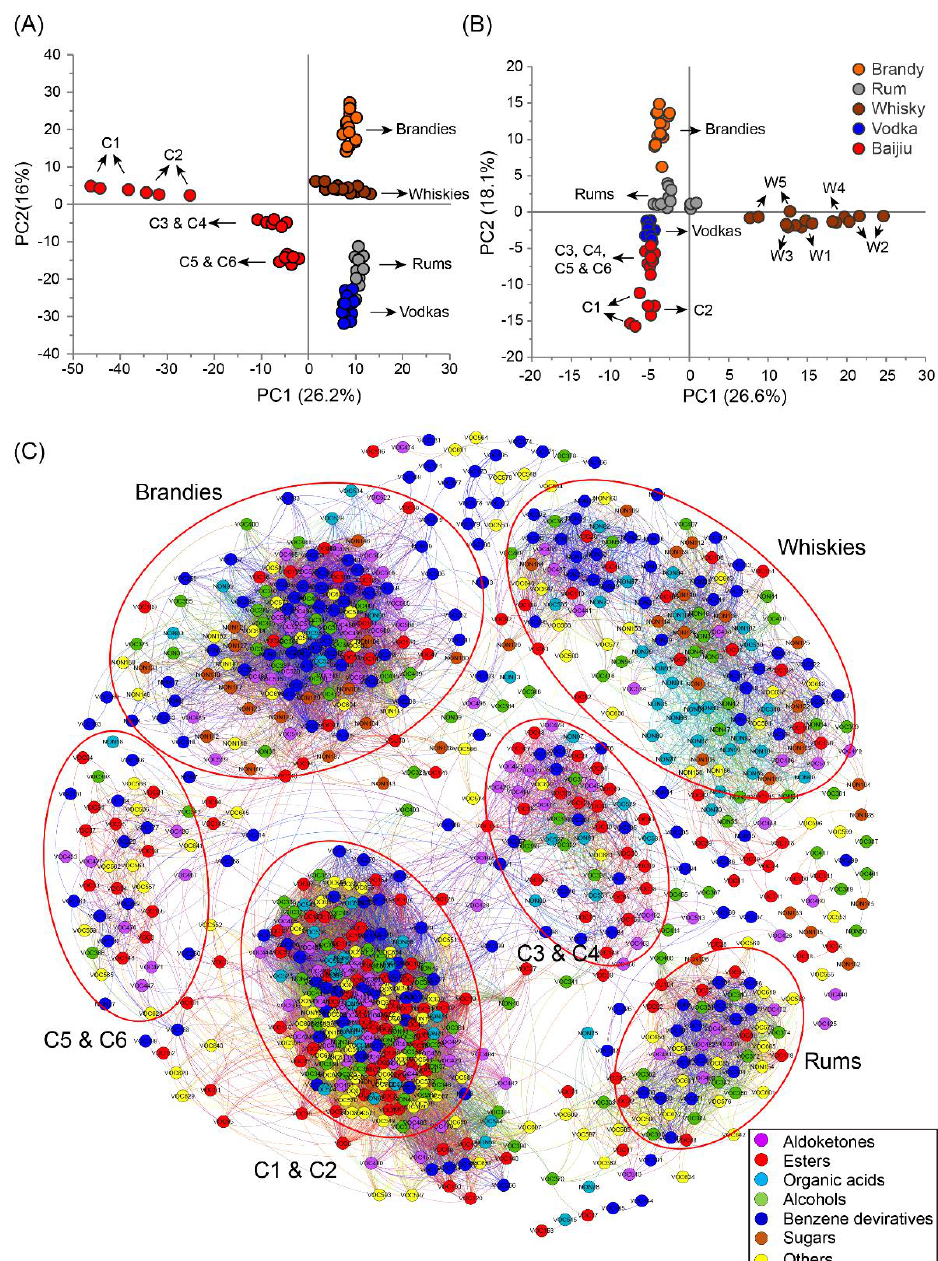
Figure 3. Principal component analysis (PCA) and correlation network analysis of 24 distilled liquors, including 6 Chinese baijius and 18 Western liquors. ( A ) Plot of PCA scores of VOCs detected by HS-SPME-GC-TOFMS (R2X = 0.962, Q2 = 0.863). ( B ) Plot of PCA scores of non-VOCs detected by GC-TOFMS (R2X = 0.902, Q2 = 0.745). ( C ) Network analysis clustering 777 significantly (FDR < 0.05) correlated compounds into six groups.